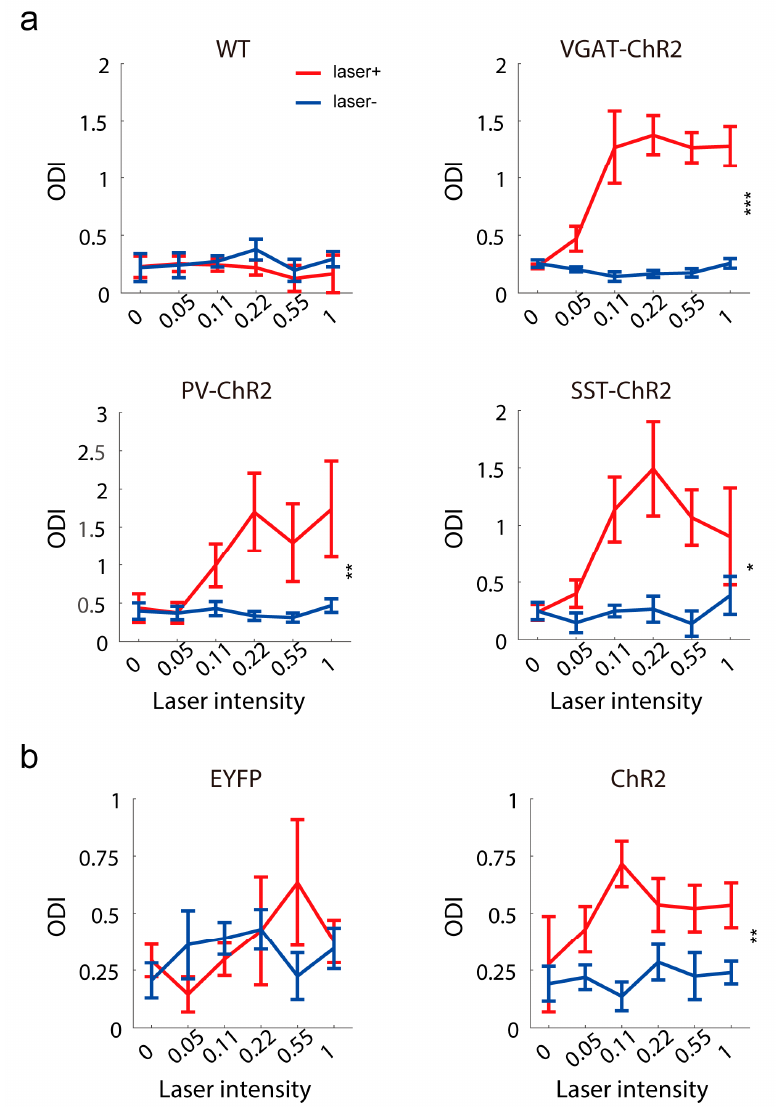
Figure 5. Ocular dominance changes induced by the activation of contralateral inhibitory neurons.